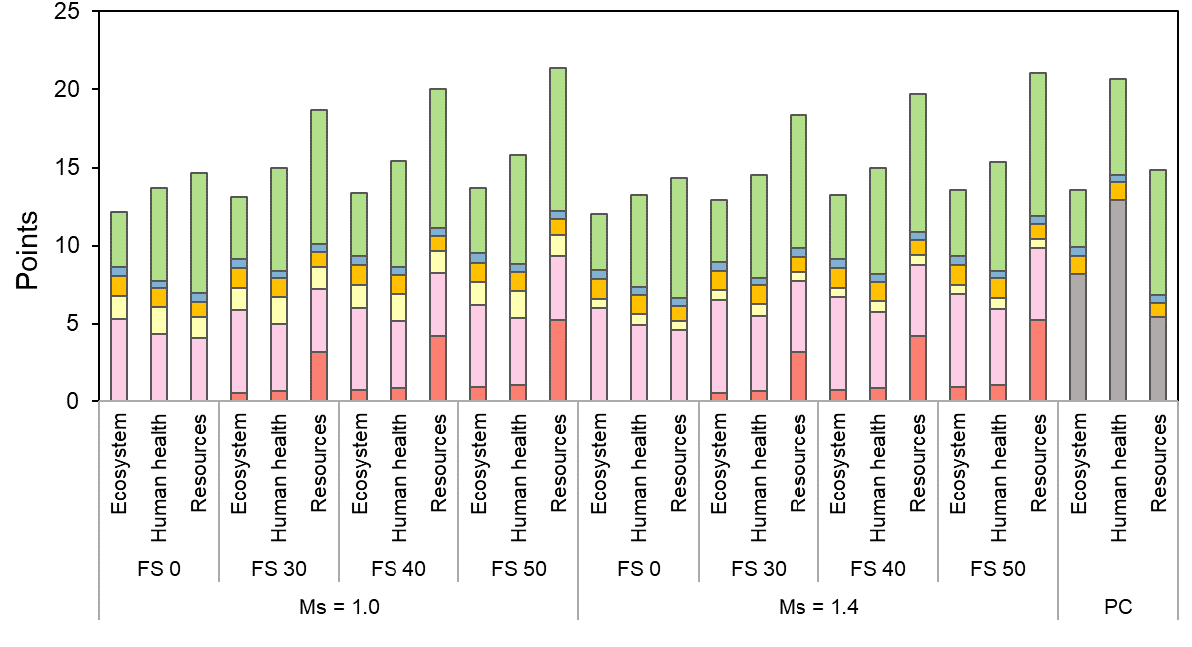
Figure 29. Endpoint environmental impact assessment of AAC and PC concrete.